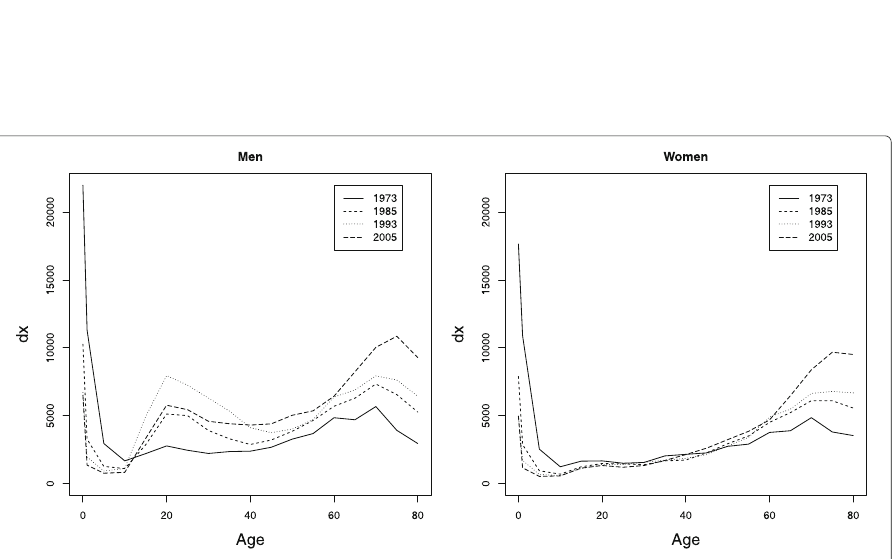
Fig. 12 Evolution of the death curve, Colombia, census years, men and